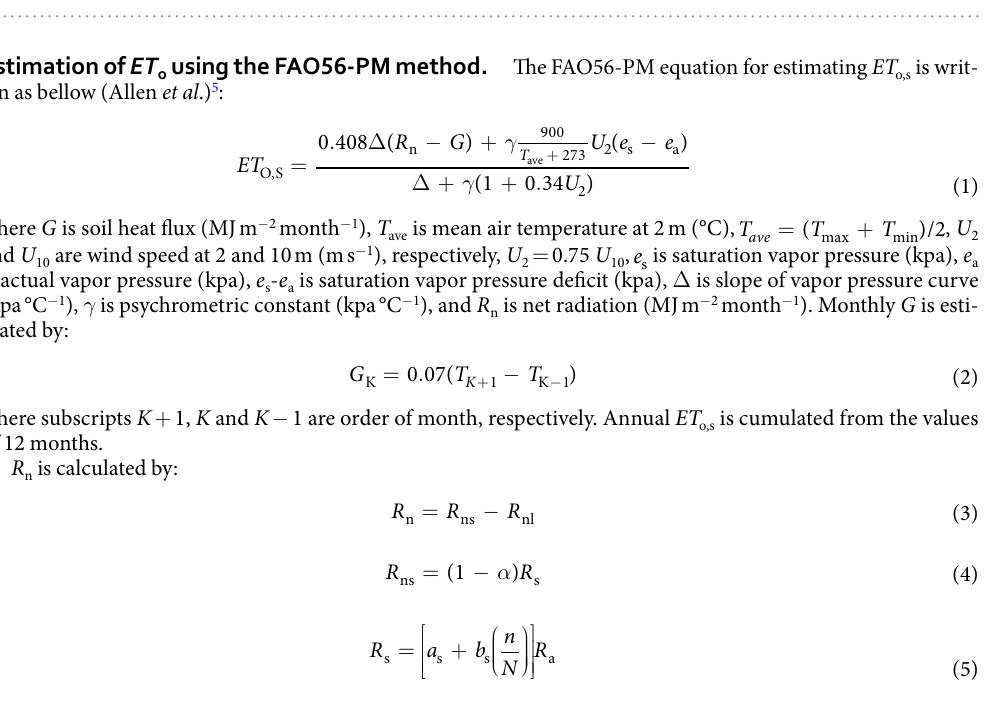
Figure 1. The DEM, weather station distribution and the sub-region division (I to VII) in China. (ArcGIS 10.2, http://map.baidu.com, Lingling